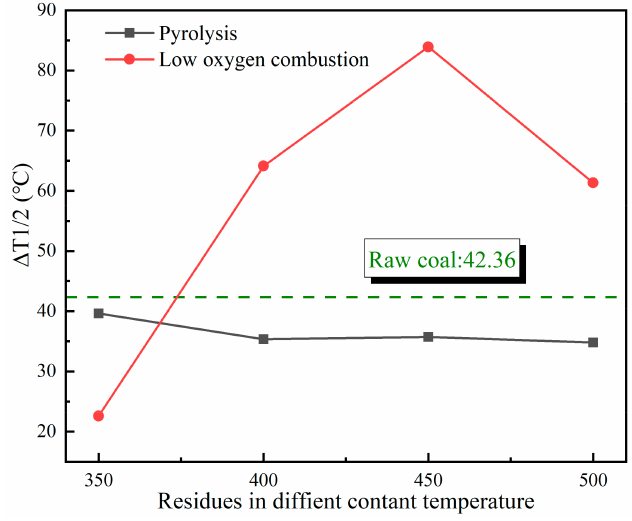
Figure 9. Laws of combustion half peak width, ∆ T 1/2 , of coal pyrolysis and low oxygen combus- tion